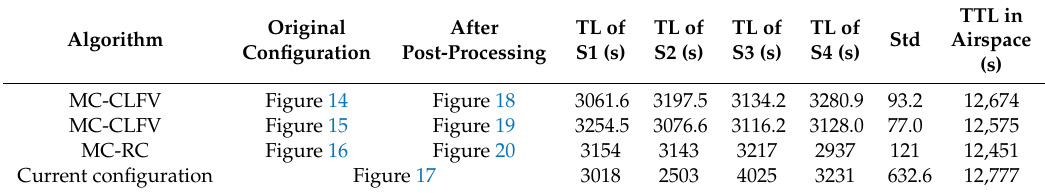
Table 6. Comparison of results between the MC-CLFV algorithm and MC-RC